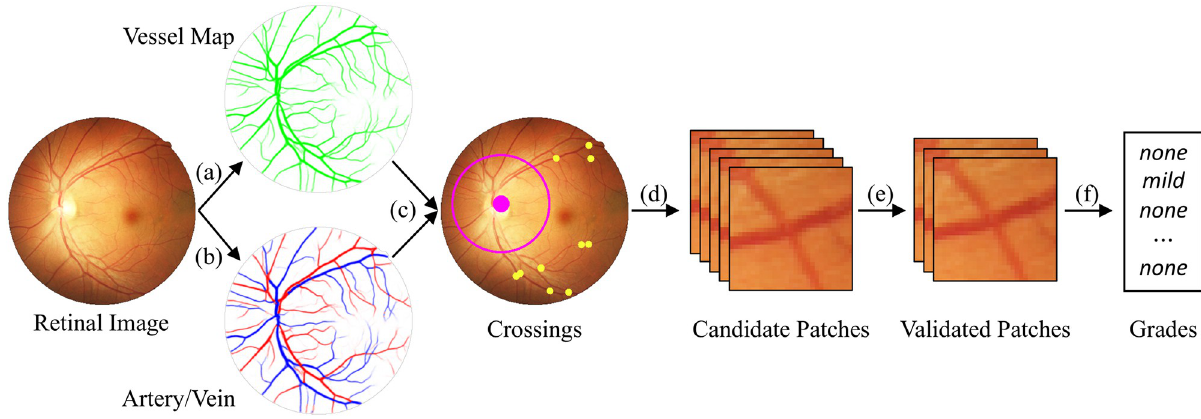
Fig 2. Overall pipeline of our severity